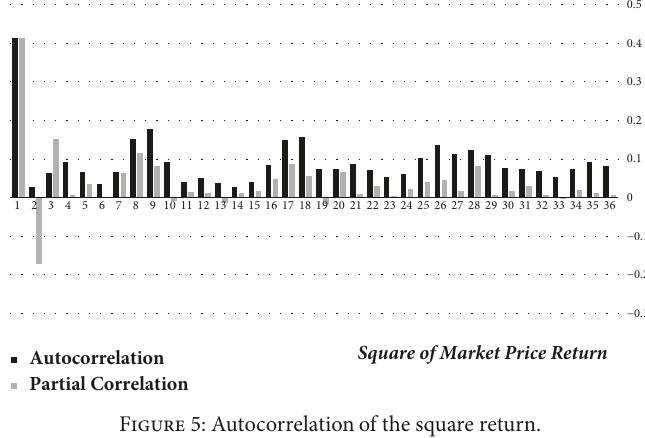
Figure 5: Autocorrelation of the square return.